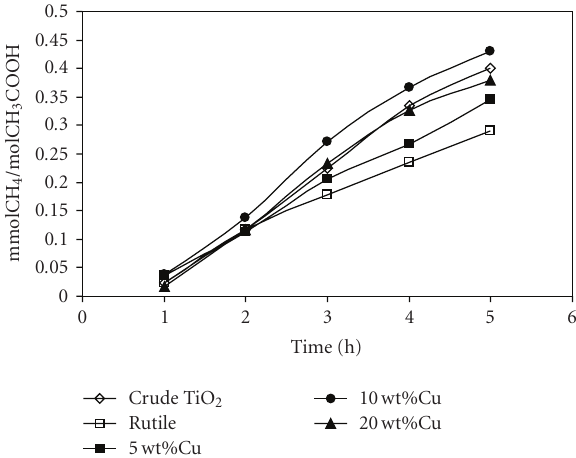
Figure 3: Photocatalytic generation of methane on di ff erent photo- catalysts.